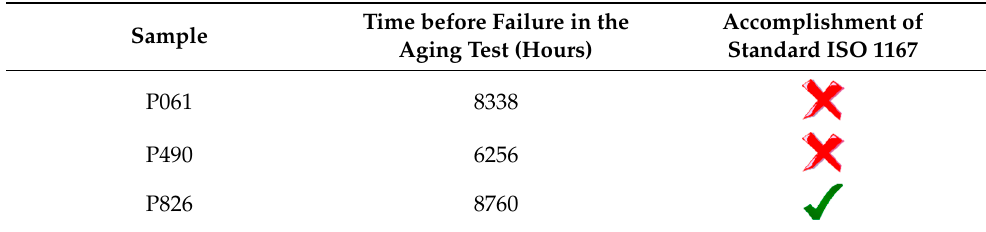
Table 1. Commercial labels and time before failure for the normalized aging test in the different PP-R pipes.